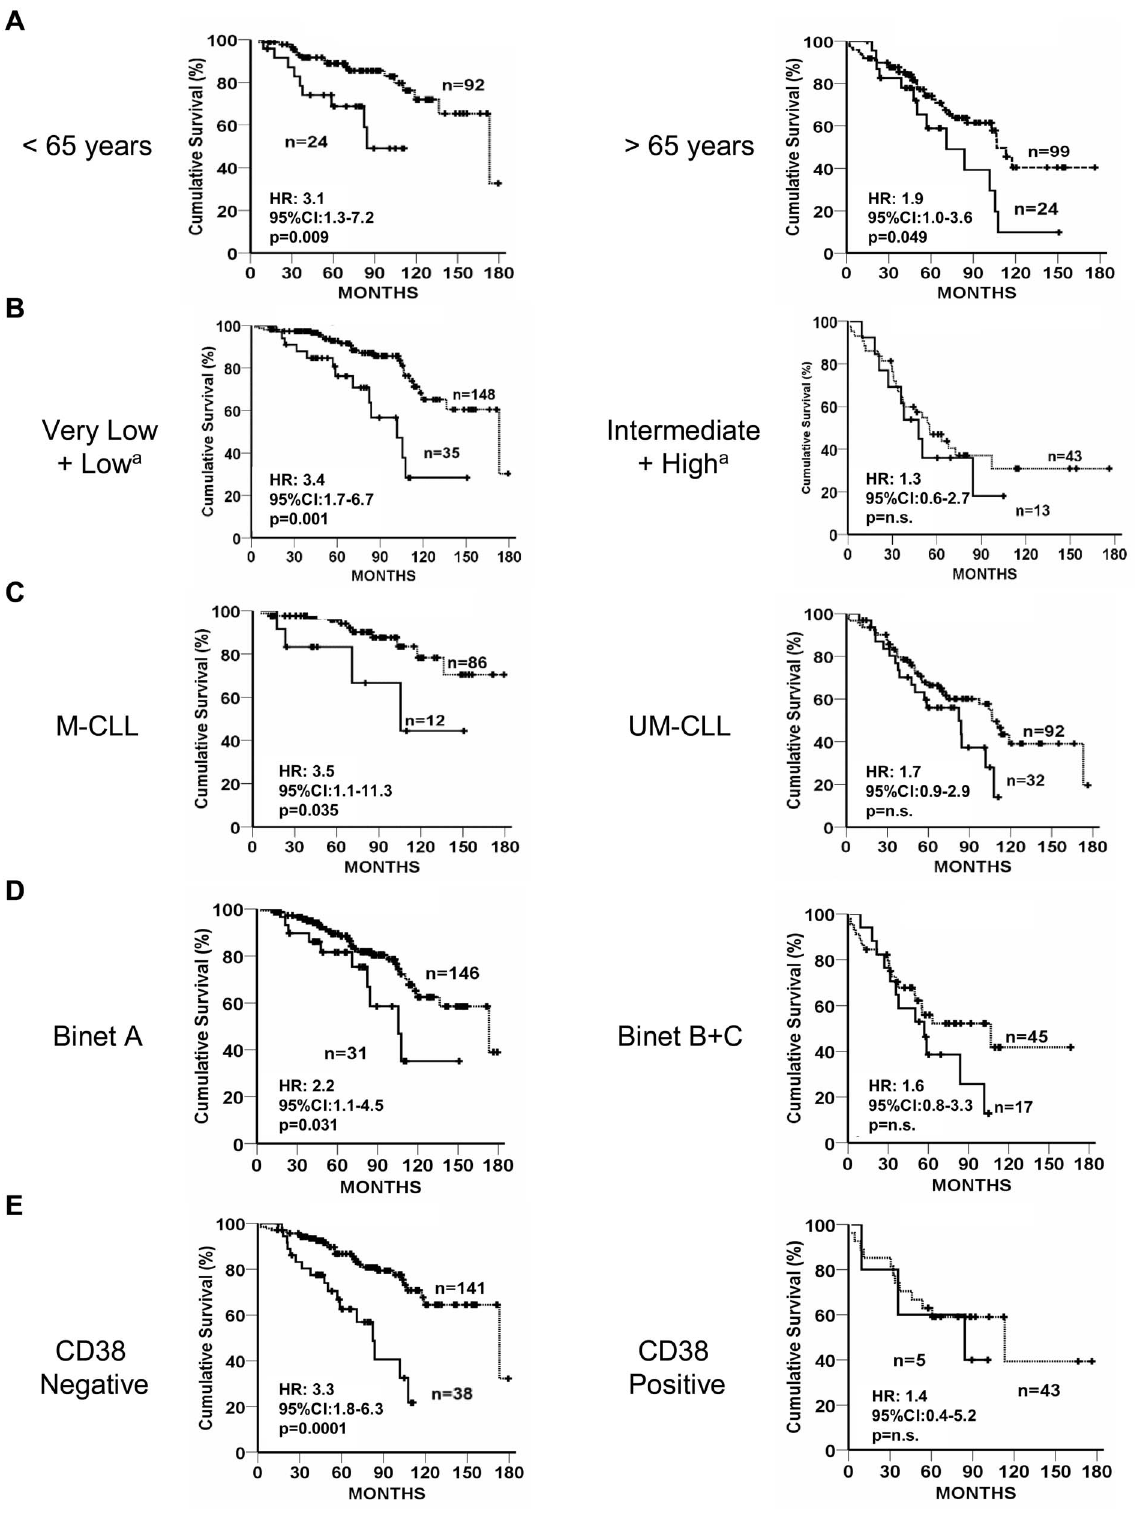
Figure 2. Association of VEGFA ACG + / + genotype and OS of CLL patients with good prognostic features. Kaplan-Maier curves according to VEGFA ACG + / + genotype (solid line) and other genotypes (dotted line) in subgroups of patients divided by (A) age at diagnosis, (B) IgVH mutational status, (C) Binet stage, (D) CD38 status and, (E) genetic abnormalities. a Very low (del13q), low (normal karyotype), intermediate ( D ATM ) and high-risk ( D TP53 ).